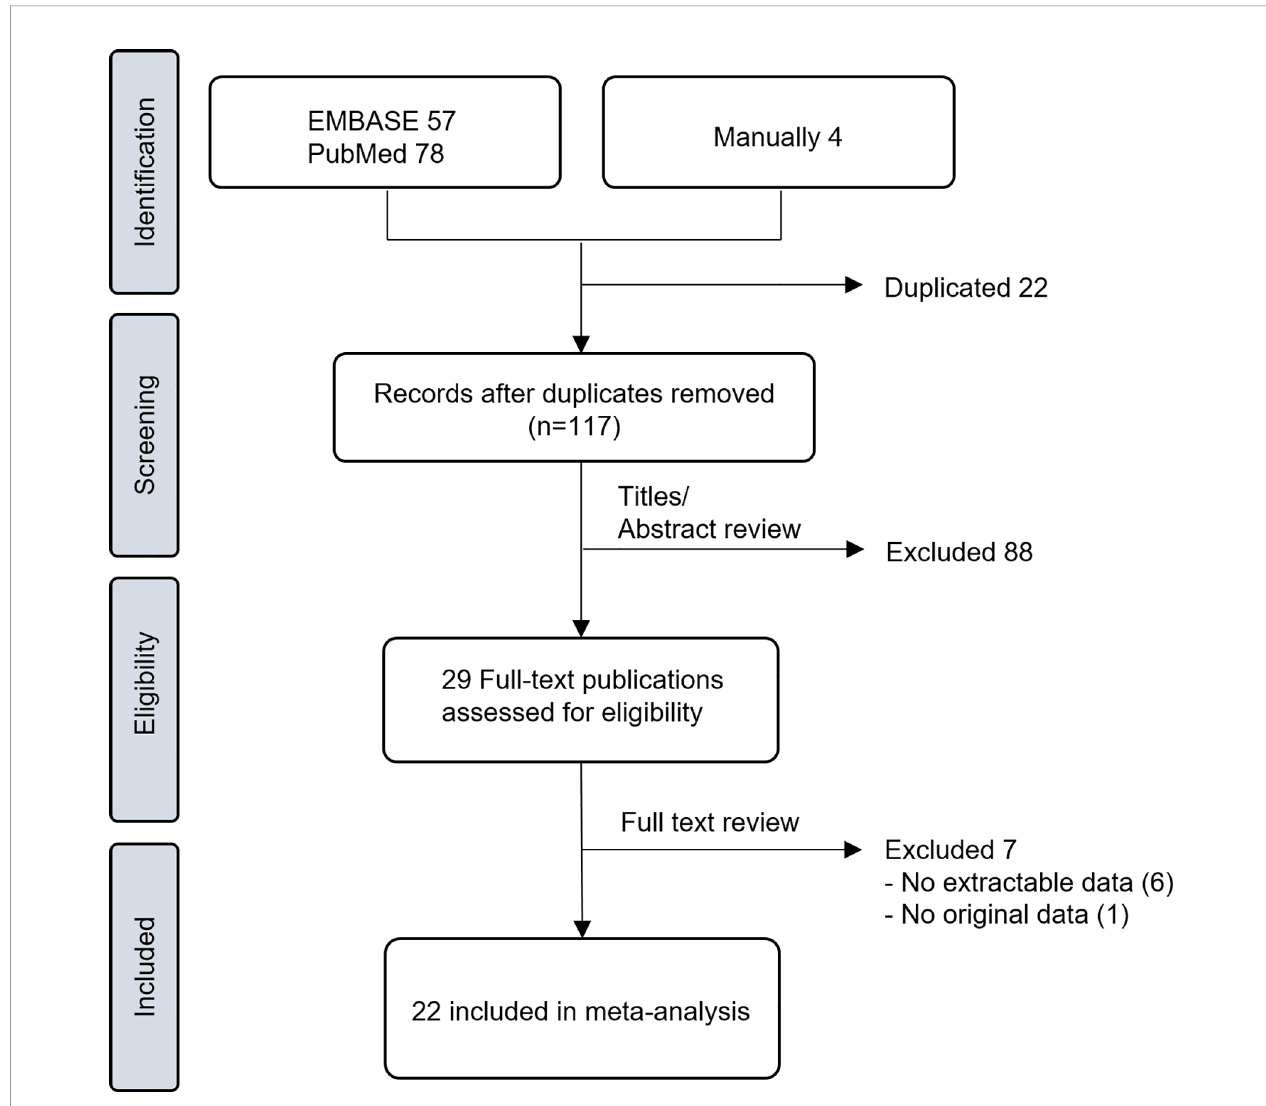
FIGURE 1 | Flow diagram of study